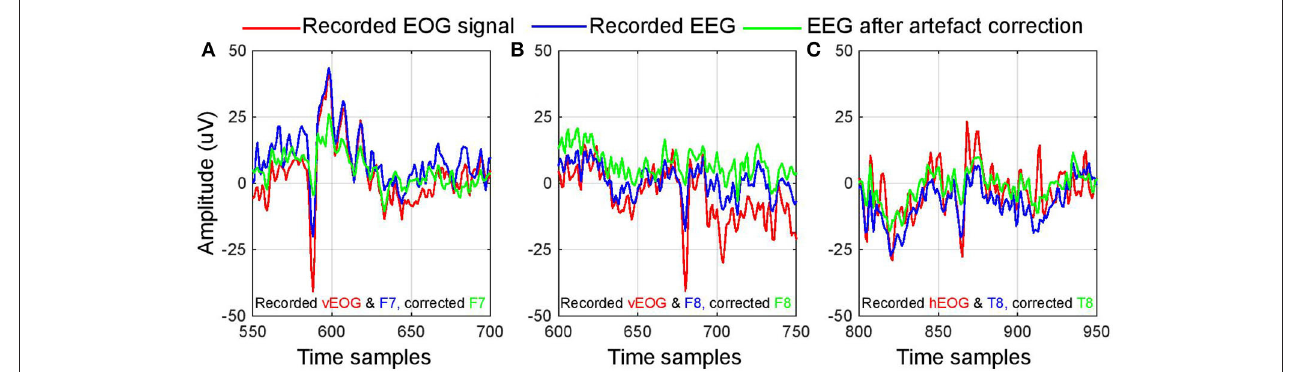
FIGURE 3 | Demonstration of artifact removal. (A–C) Illustrates three different instances of artifact correction employed in the BCI used in this research. The blue line indicates a segment of data that the algorithm identified as corrupted by ocular artifact and the red line indicates the simultaneously recorded electrooculugram (EOG) signals. The green line displays the same segment after correction, with visibly reduced EOG